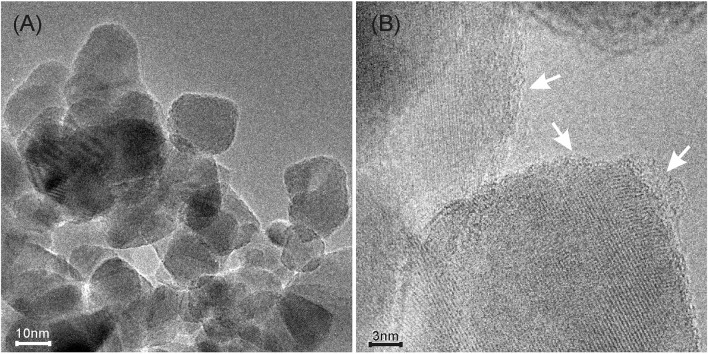
(A) TEM image of p-C2H2/MoS2/TiO2 sample; (B) HRTEM image of the same sample showing the carbon based envelope originated after exposure to C2H2 (highlighted by white arrows).